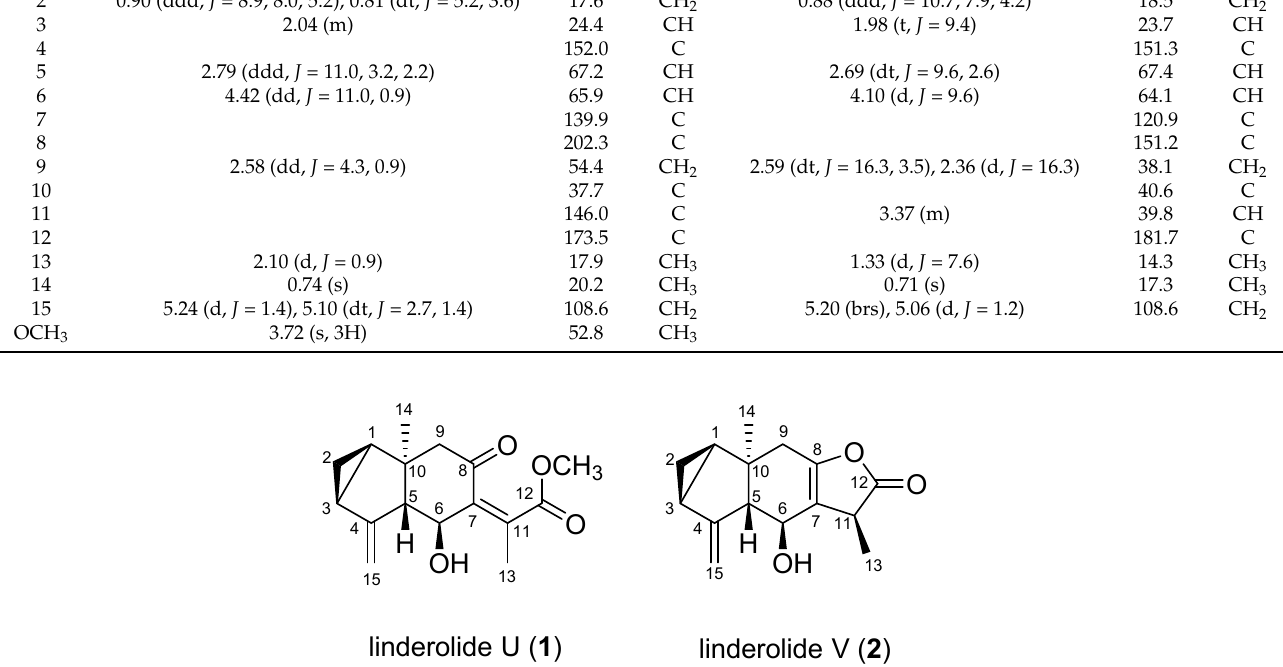
14.3), three methylenes (at δ C 18.56, 38.1, 108.6), three methines (at δ C 28.4, 23.7 and 67.4), one oxymethine (at δ C 64.1), and five quaternary carbons. In the 1 H NMR spectrum, two methyl signals at δ H 0.71 (s) and 1.33 (d), one hydroxymethine at δ H 4.10 (1H, d, J = 9.6), three methines at δ H 1.52 (1H, dt, J = 7.5, 3.9), 1.98 (1H, t, 9.4) and 3.37 (1H, m), and char- acteristic exo -methylene resonances at δ H 5.06 and 5.20 were observed. The correlations of –CH(H-1)–CH 2 (H-2)–CH(H-3)- and –CH(H-5)–CH(H-6) were observed in the 1 H- 1 H COSY spectrum. In the HSQC spectrum, one oxymethine carbon was observed at δ C 64.1, connected to δ H 4.10 (1H, d, J = 9.62). Besides, three methines were also revealed at δ C 28.4, 23.7 and 67.4, corresponding to δ H 1.52 (1H, dt, J = 7.5. 3.9), 1.98 and 2.69, respectively. In the HMBC spectrum, correlations were observed from H-15 to C-3/C-5/C-4, from H-14 to C-1/C-5/C- 10, from H-13 to C-7/C-11/C-12, from H-2 to C-1/C-3/C-4/C-10 and from H-9 to C-2/C-5/C- 7/C-8/C-10, from H-6 to C-7/C-8. The chemical structure of 2 was similar to the previously reported compound, shizukanolide [20], but the double bond position C-7/C11 was changed to C7/C8 (Figure 4). Based on the obtained data, compound 2 was determined as shown in Figure 4 and was named linderolide V. The relative stereochemistry of 2 was determined by NOESY, which showed correla- tions between CH 3 -14 and H-6 which suggested that these protons exist on the same side. CH 3 -13 and H-5 also showed a correlation that means these protons are on the same side. However, CH 3 -13 and CH 3 -14 did not show any correlations that are located on the oppo- site side (Figure 5). The coupling constant between H-5/H-6 was 9.6 Hz which supported that H-5 and H-6 were located on the other side. In addition, the Δ δ values between the ( S ) and ( R )-MTPA esters indicated the 6 S configuration for 2 (Supplementary Materials Figure S19) [18]. Figure 5. Key HMBC (H